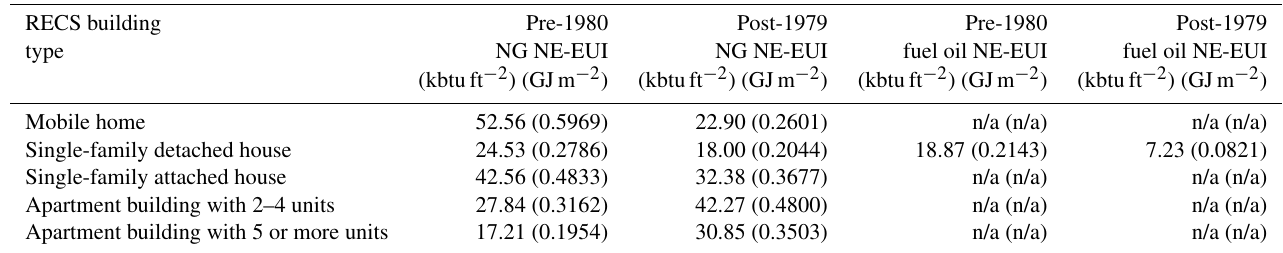
Table 2. Residential NE-EUI survey values by building type from the Residential Energy Consumption Survey (RECS).